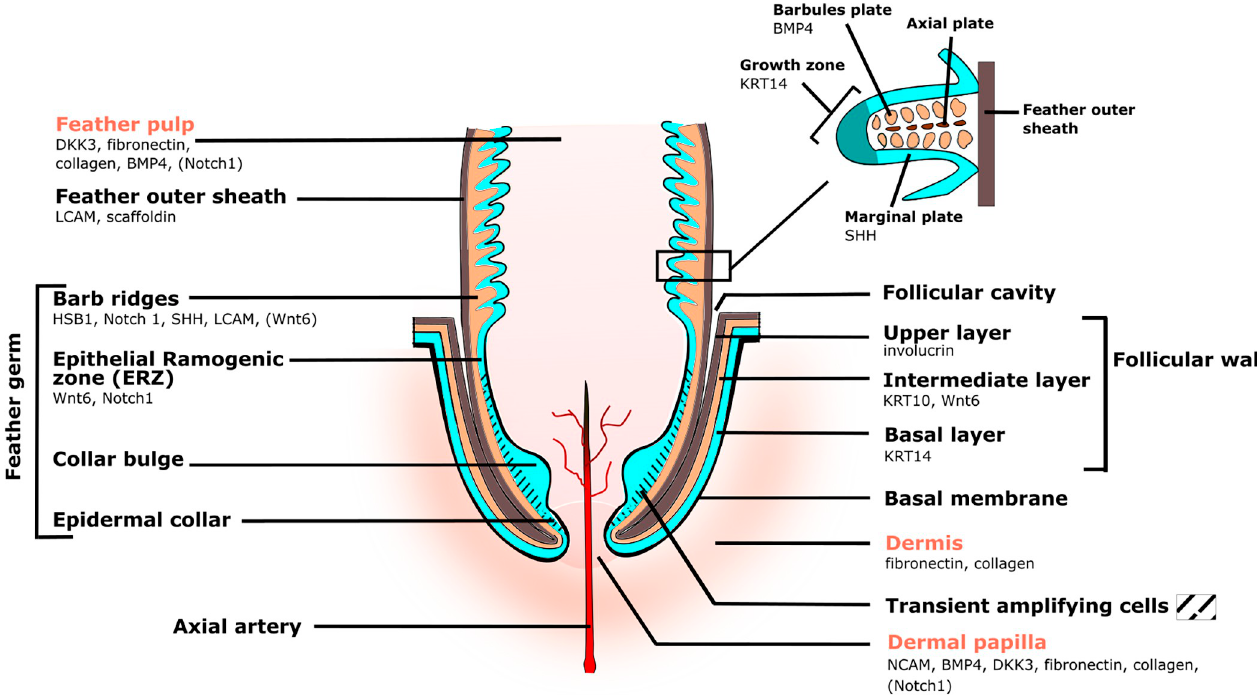
Fig 1. Schematic representation of a feather follicle with a growing feather. Adapted from [4]. Legends for the mesenchymal compartment appear in pink. It includes the dermis, the dermal papilla, and the feather pulp. Legends for the epidermal compartment appear in black. The epithelia (follicular wall and feather epithelium) are made of three layers: the basal layer (in blue), the intermediate layer (in orange), and the upper layer (in brown). The feather outer sheath surrounds and protects the feather germ. The feather germ epithelium is composed of four structures from the bottom to the top: i) the epidermal collar, ii) the collar bulge, iii) the epithelial ramogenic zone (ERZ), and iv) the barb ridges. Transiently amplifying cells (hatched area) are localized in the proliferative zone. The basal layer involuted into barb ridges is called the marginal plate. As shown in the enlargement (black frame) of one barb ridge, the basal layer/marginal plate proliferates at barb ridges extremity, thus providing numerous barbs and/or barbules cells. This allows the formation of the axial and barbule plates which give rise to barbs and barbules, respectively. The space between the follicular wall and the feather outer sheath is the follicular cavity. The feather follicle is irrigated by a prominent axial artery. Gene markers expressed in various zones of the FF and used in this study are indicated below each corresponding structure.